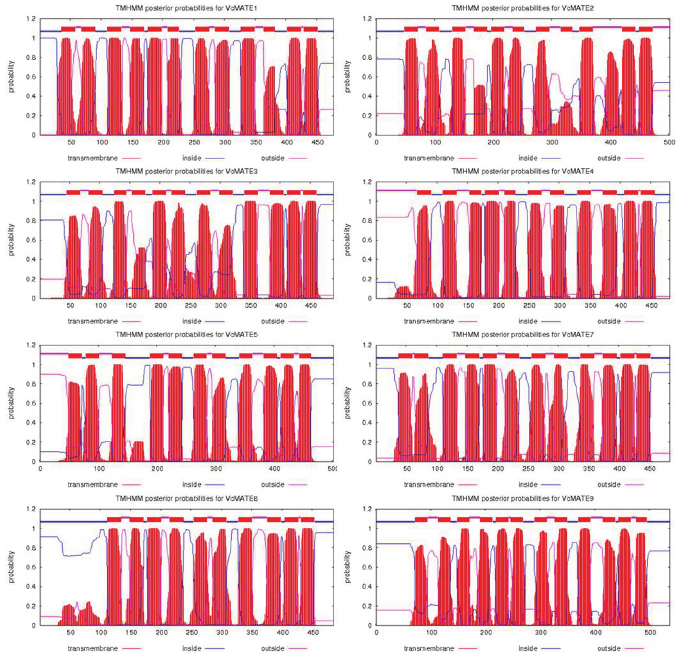
Fig 2. Topological analysis of VcMATEs. The membrane-spanning domains of VcMATEs were determined using the TMHMM2 program.